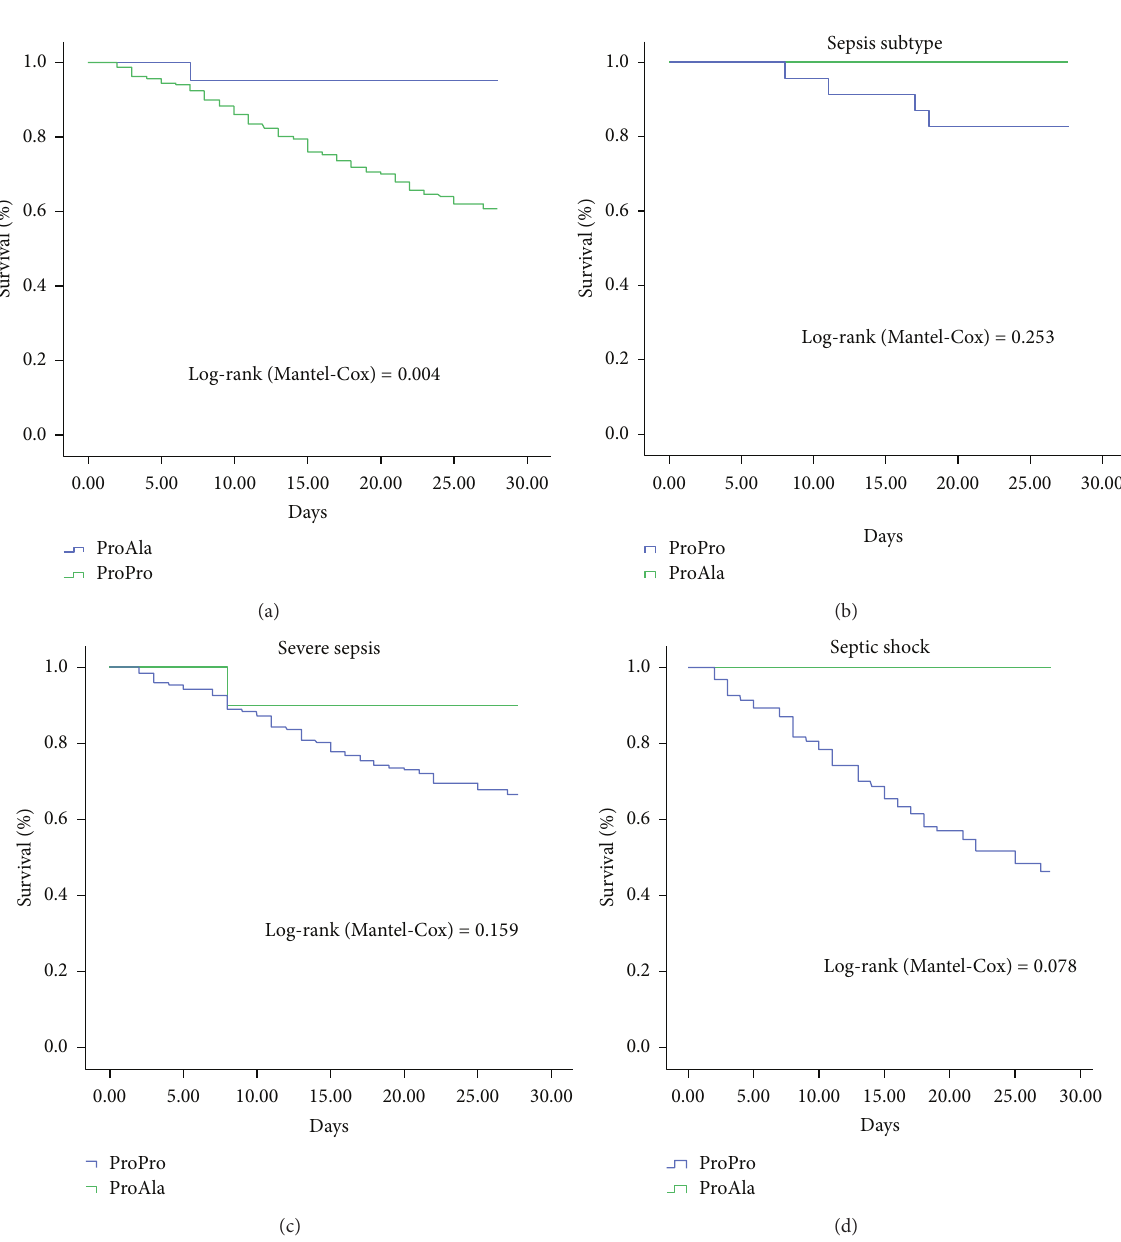
Figure 1: 28-day survival rates of patients with sepsis. Kaplan-Meier estimates were used to calculate the probability of 28-day survival according to the PPAR- 𝛾 Pro12Ala genotype. The carriers of the Pro12Pro genotype had significantly decreased 28-day survival compared with the carriers of the Pro12Ala genotype. (a) Pro12Pro carriers versus Pro12Ala carriers; (b) Pro12Pro carriers versus Pro12Ala carriers in Sepsis subtype subgroup; (c) Pro12Pro carriers versus Pro12Ala carriers in severe sepsis subgroup; (d) Pro12Pro carriers versus Pro12Ala carriers in severe sepsis subgroup in septic shock subgroup.